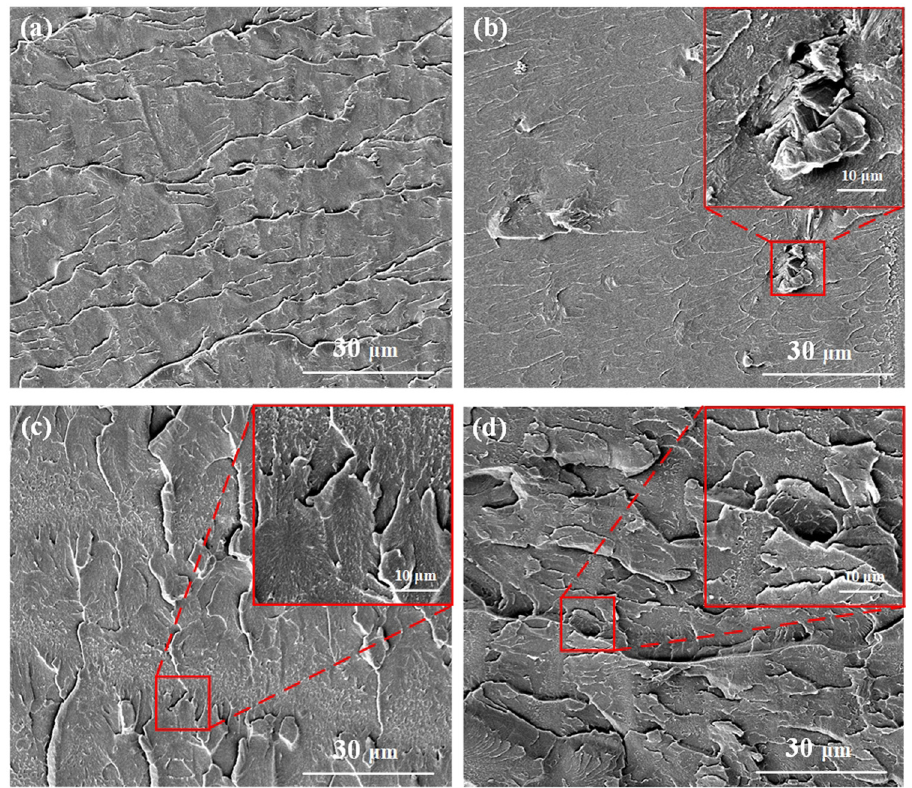
Figure 2: SEM images of SMGO/EP composites with the GO content of ( a ) 0 vol%, ( b ) 0.5 vol%, ( c ) 1.0 vol%, and ( d ) 1.5